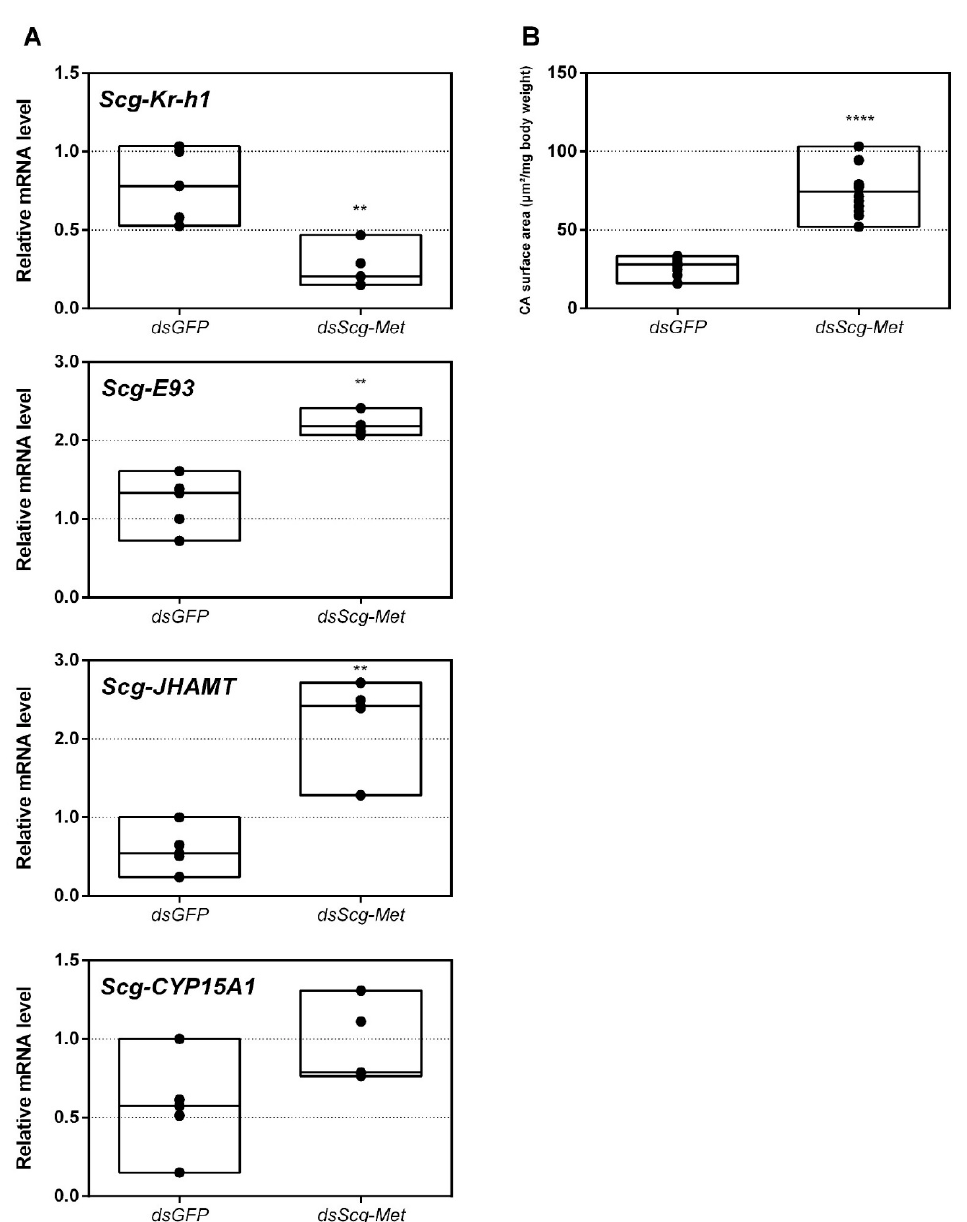
Figure 2. ( A ) Relative mRNA levels of Scg-Krh1, Scg-E93, Scg-JHAMT and Scg-CYP15A measured in the corpora allata (CA) of dsGFP and dsScg-Met injected adult male desert locusts 34 days after the adult molt. Data highlight the reduced Scg-Krh1 transcript levels, as well as the increased Scg-E93 and Scg-JHAMT transcript levels, in the CA after Scg-Met silencing. No significant change in the transcript levels of Scg-CYP15A1 was detected. Transcript levels in the CA were normalized against two reference genes, Scg - Act and Scg - Ef1a . Data points are represented in a column graph as a floating bar (min to max value) with a line indicating the median. For every condition five biological replicates, each consisting of the pooled CA samples from four individual locusts, were analyzed by q-RT-PCR. Significant differences (Mann-Whitney U-test) are indicated with asterisks (** p < 0.01; **** p < 0.0001). The following statistical p-values were obtained: Scg-Kr-h1 ( p = 0.0079), Scg-E93 ( p = 0.0079), Scg-JHAMT ( p = 0.008), Scg-CYP15A1 ( p = 0.06). ( B ) Normalized surface area of the CA in µ m 2 /mg body weight of dsGFP and dsScg-Met treated animals. These data demonstrate that the CA significantly increased in size after dsScg-Met treatment. Data points are represented in a column graph as a floating bar (min to max value) with a line indicating the median. For each condition 13 animals were dissected for their CA. Significant differences (Student’s T-test) are indicated with asterisks (**** p < 0.0001). (Abbreviations: ds = double stranded, Scg = Schistocerca gregaria , GFP = Green Fluorescent Protein, Met = Methoprene-tolerant, Kr-h1 = Krüppel-homolog 1, JHAMT = JH acid methyltransferase, CA = corpora allata , Act = actin, Ef1a = elongation factor